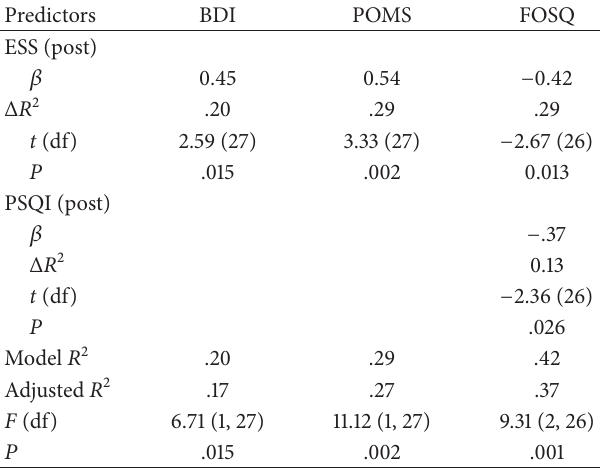
Table 3: Prediction of psychosocial outcomes in participants with OSA treated with CPAP using stepwise